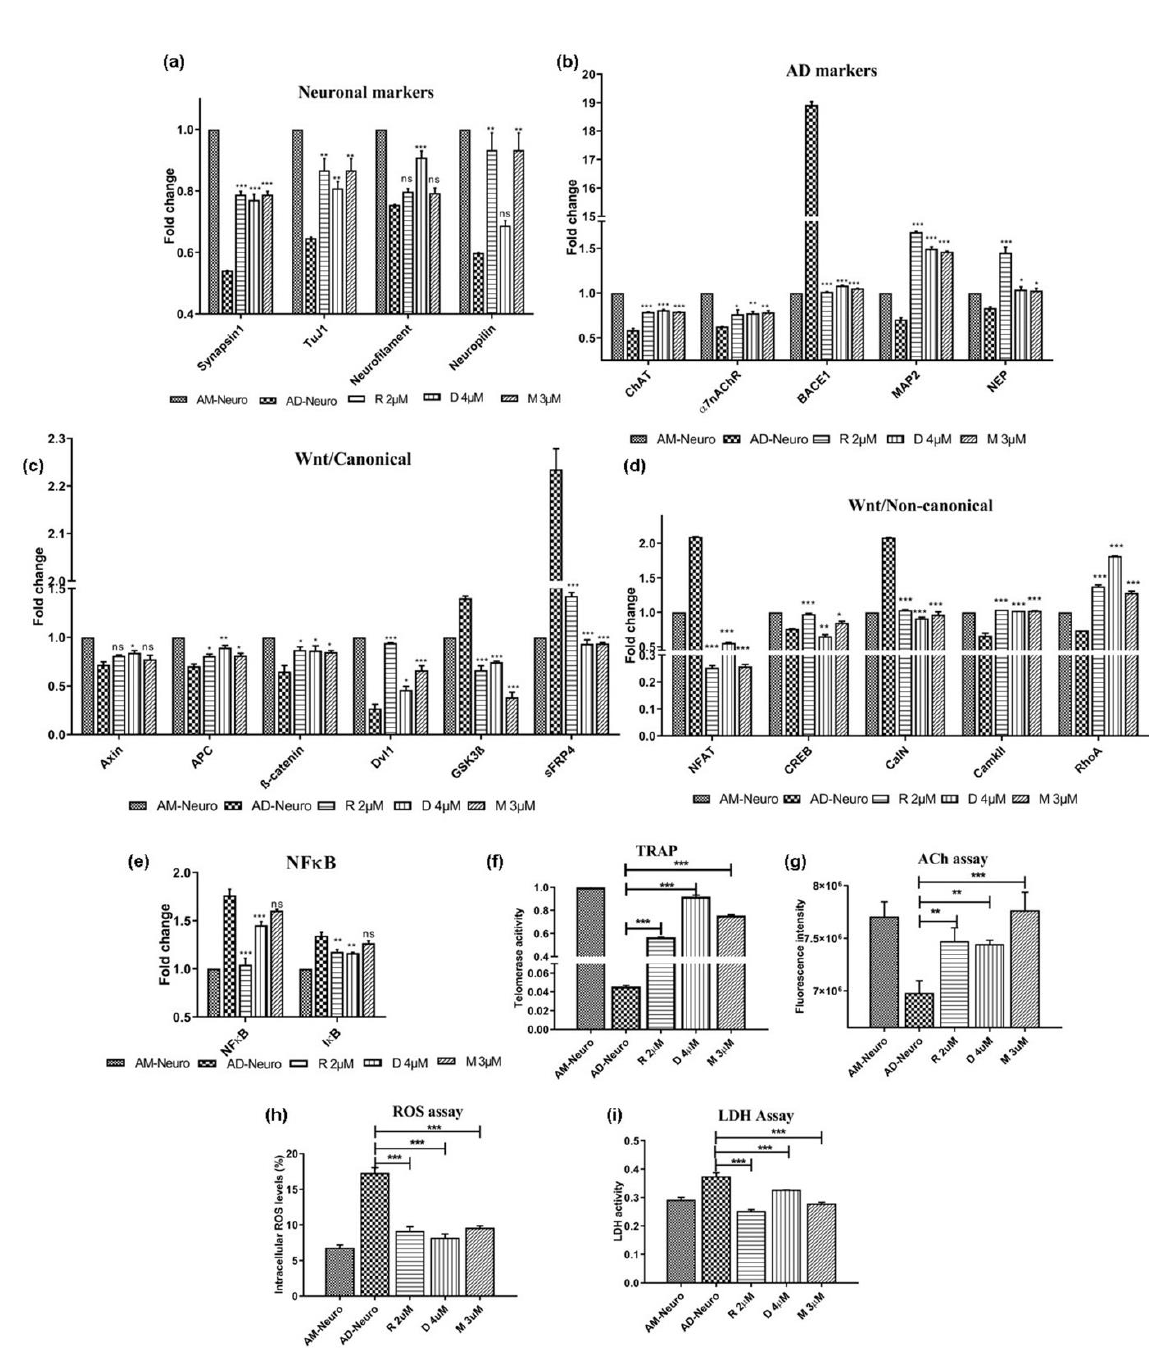
Figure 5. Effect of commercial AD drugs rivastigmine (R), donepezil (D) and memantine (M) on Aβ 1 – 42 -mediated degeneration in vitro; qRT-PCR analysis of AD-Neuro cells treated with R, D and M for ( a ) neuronal markers: synapsin1, tuj1, neurofilament and neuropilin, ( b ) AD-associated markers: ChAT, α 7nAChR, BACE1, MAP2 and NEP, ( c ) Wnt/canonical pathway markers, GSK3 β , sFRP4, Axin, APC, β -catenin and Dvl1, ( d ) Wnt/non-canonical pathway markers, NFAT, CREB, CalN, CaMKII and RhoA and ( e ) NF κ B and I κ B. Data are represented as mean with SEM ( n = 3), * p < 0.05, ** p < 0.01 *** p < 0.001. ( f ) TRAP assay showing increase in telomerase activity in AD-Neuro cells upon treatment with drugs R, D and M at 2 µM, 4 µM and 3 µM respectively. ( g ) Increase in acetylcholine (ACh) in terms of fluorescence intensity in the cells treated with drugs as compared to AD-Neuro, ( h ) lowering of intracellular ROS production and ( i ) decrease in LDH activity in the drug treated AD-Neuro cells. Data are represented as mean with SEM ( n = 3), ** p < 0.01 *** p < 0.001.